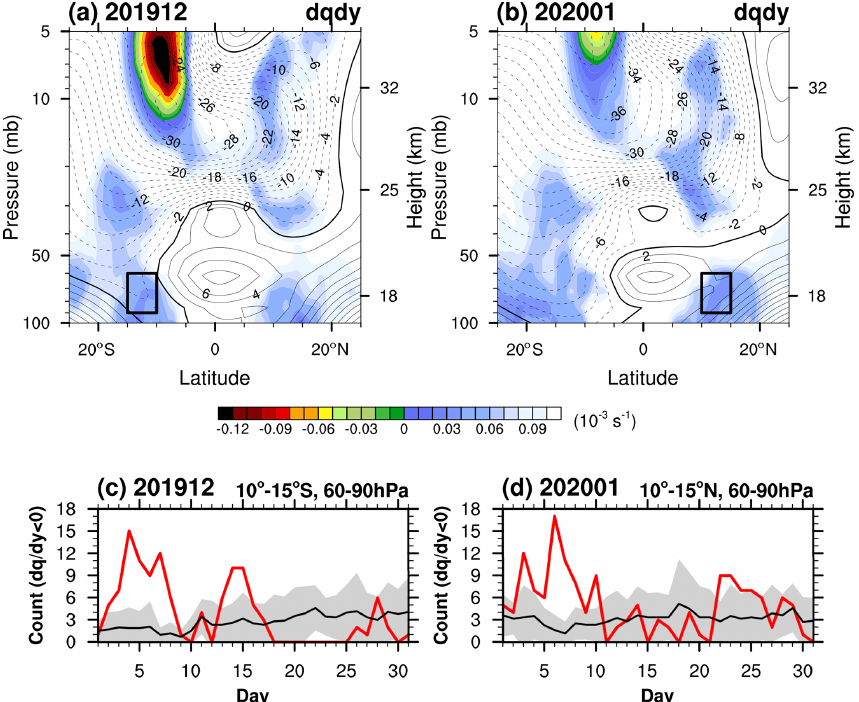
Figure 8. Monthly averaged meridional potential vorticity gradient in a latitude–height cross section (shading) overlaid with the zonal-mean zonal wind (contour) in (a) December 2019 and (b) January 2020. The solid (dashed) lines indicate westerly (easterly) winds with an interval of 2ms − 1 , and thick solid lines indicate a zero zonal wind speed. Time series of the number of grids with negative daily mean q φ (s − 1 ) in the (c) boxed region in the SH (10–15 ◦ S, 60–90hPa) in December 2019 and (d) that in the NH (10–15 ◦ N, 60–90hPa) in January 2020 (red). The black lines in Fig. 8c and d correspond to the climatology with ± 1SD (gray shading).